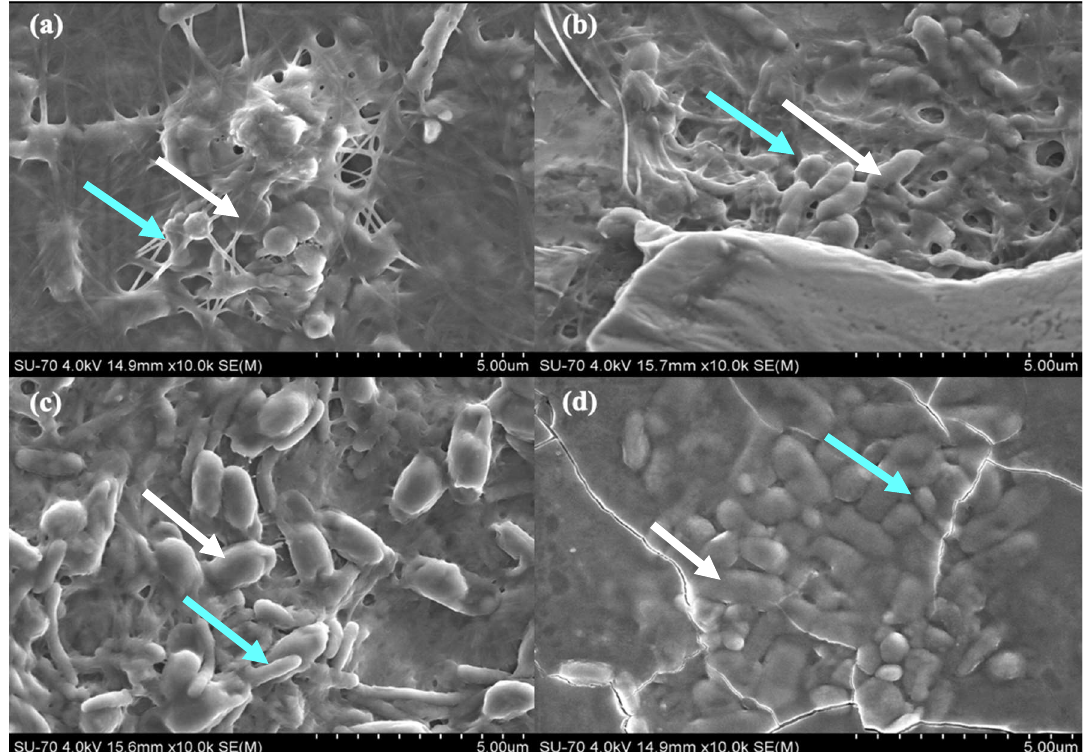
Figure 6. SEM micrograph of symbiotic biofilms produced by bacteria K. saccharivorans (blue arrow) and microalgae C. debaryana presence (white arrow), at 30 °C after 14 day incubation, in different HS:BG-11 symbiotic media ratio: (a) 55:45; (b) 60:40; (c) 70:30; and (d) 80:20.